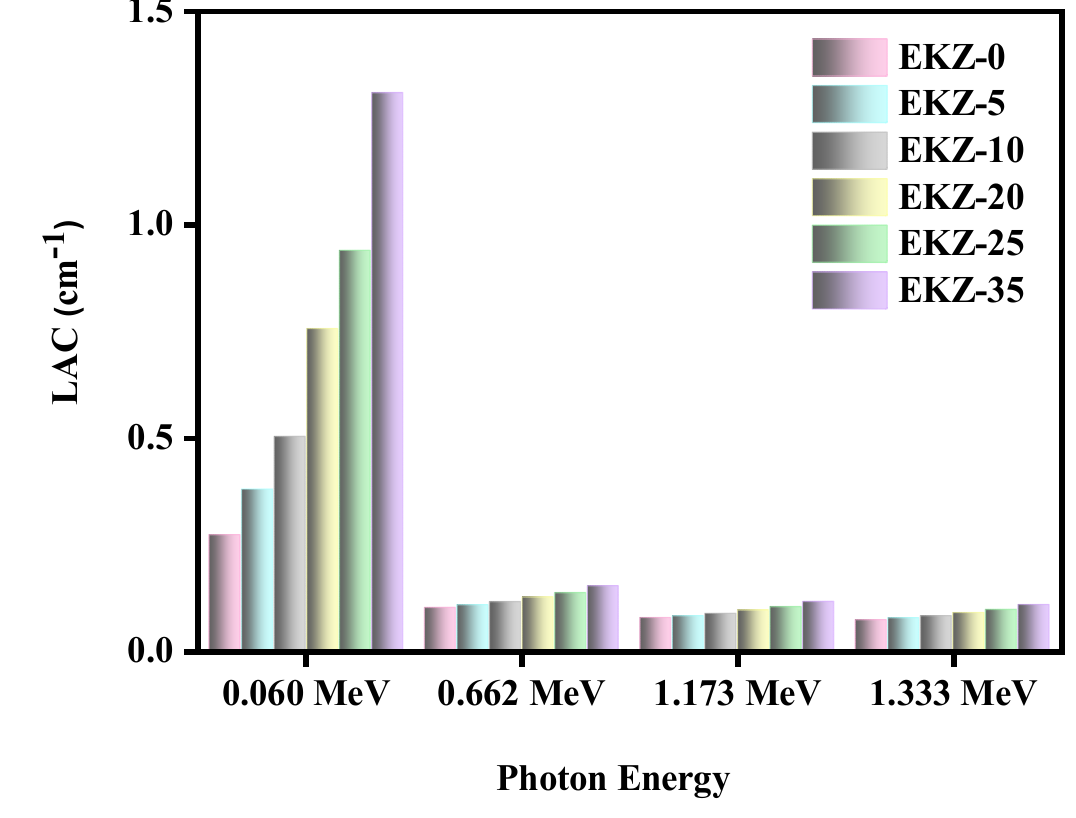
Figure 5. The LAC of EKZ samples as a function of photon